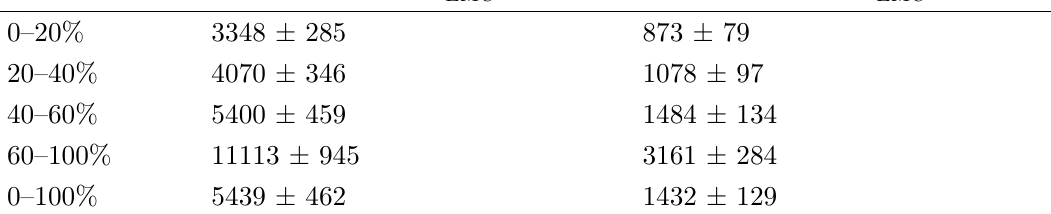
Table 2 . Values of the EMCal trigger scaling factor and their systematic uncertainties for the E cluster > 11 GeV trigger and the E cluster EMC